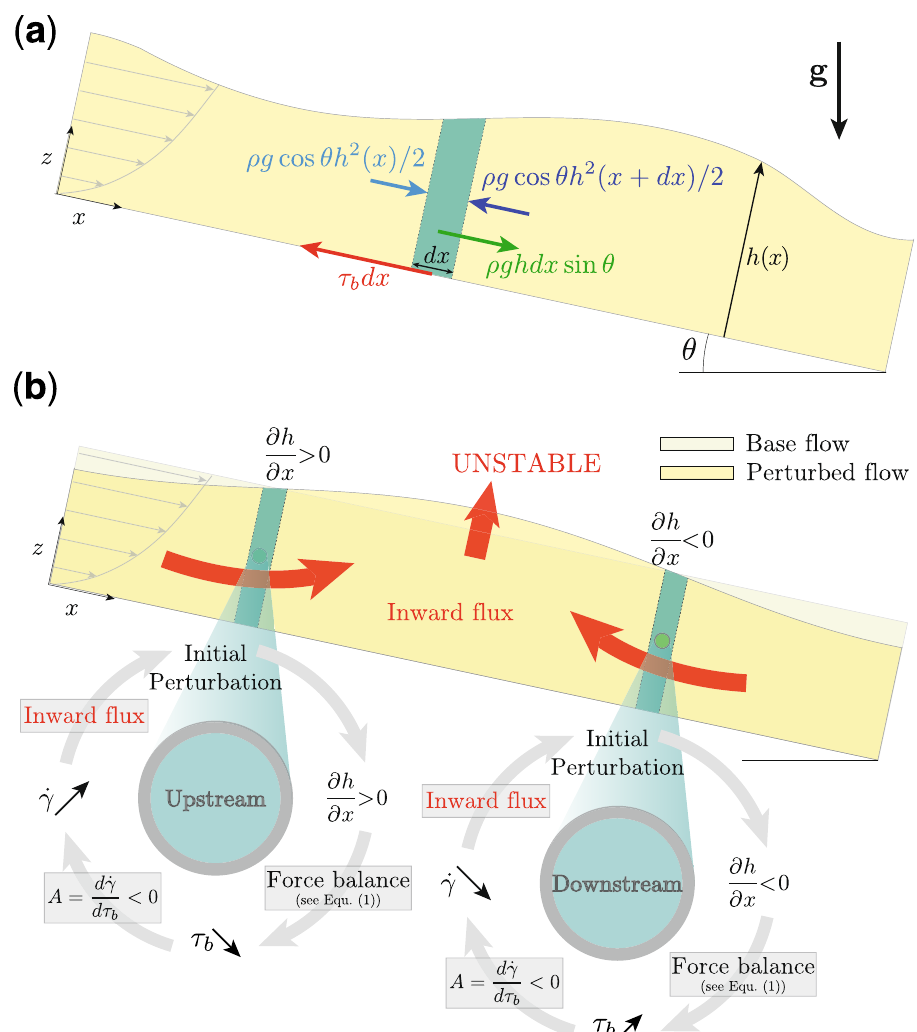
Fig. 4 Instability mechanism. a Depth-averaged forces acting along the fl ow x direction on a slice of suspension of width dx (shaded in blue): basal force τ ρ ghdx sin θ and hydrostatic pressure ρ g cos θ h 2 ð x Þ = 2, where τ fl ow b dx , projected weight of the slice b is the basal shear stress, g is gravity, h ( x ) is the thickness, θ is the plane inclination angle. b Positive feedback for a shear-thickening suspension with a S-shaped rheological curve: a local increase of the fl ow thickness h implies that ∂ h / ∂ x is positive (resp. negative) upstream (resp. downstream) of the perturbation. Force balance (see Eq. (1)) then implies that the basal shear stress τ b upstream (resp. downstream) must decrease (resp. increase). When the suspension rheogram is negatively sloped (d _ γ = d τ < 0), this yields a local increase (resp. decrease) of the fl ow rate _ γ . The combination of these two feedback cycles (gray arrows) induces a net inward mass fl ux towards the bump (red arrows) that ampli fi es the initial perturbation (red vertical